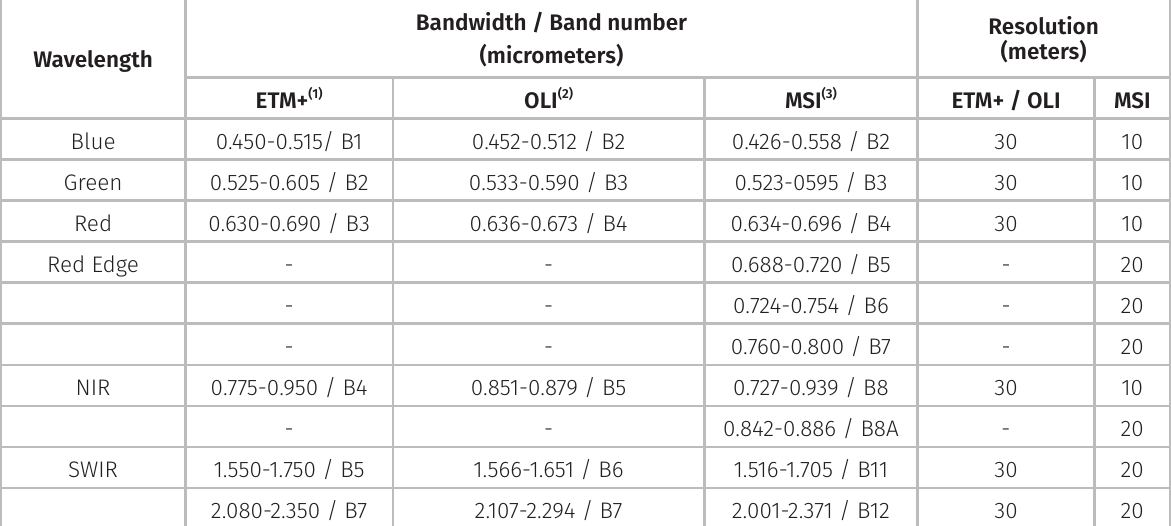
Table I. Wavelength name, satellite spectral bandwidth, band number and spatial resolution for ETM+, OLI and MSI(Sentinel-2B)